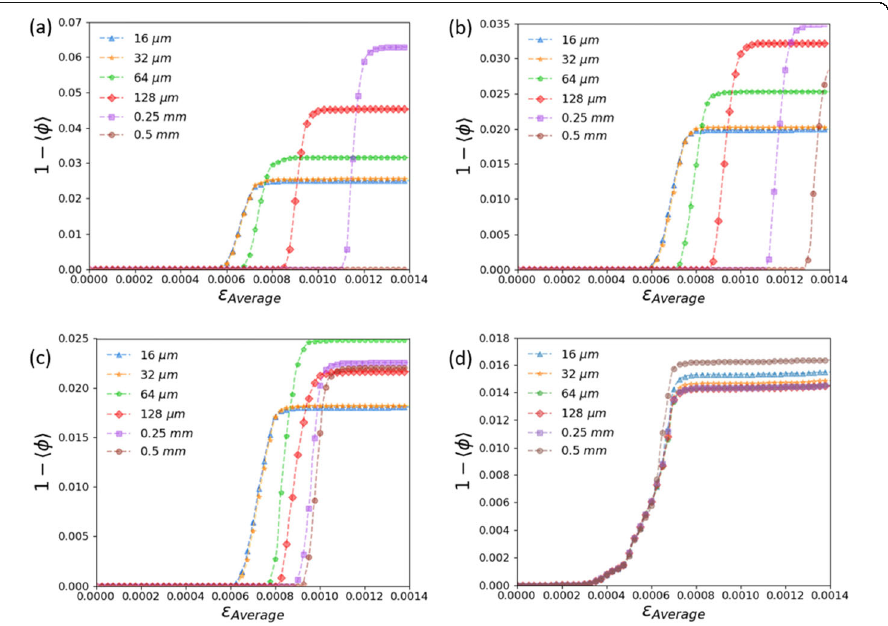
Fig. 12 Effect of disorder on average damage: The average damage of the specimens of L x = 8 μ m, L y = 0.5 mm, and L z = 1.0 mm where D = 3.995 as a function of the average strain with respect to R G where ( a ) has a R G = 0.0, ( b ) has a R G = 0.1, ( c ) has a R G = 0.2, and ( d ) has a R G = 0.4. The figure legends signify the notch width W that varies from 0.25 to 128 μ